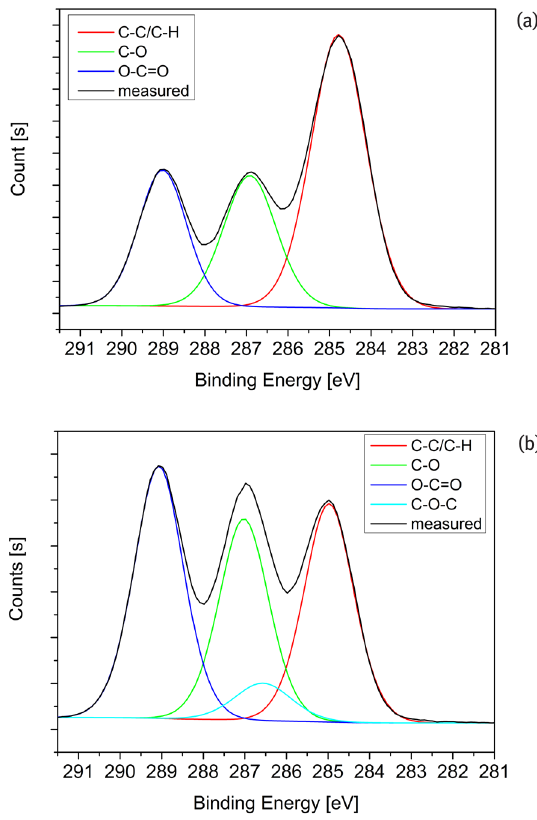
Figure 6 : C1s peak decomposition: a) untreated sample; b) after 30 s